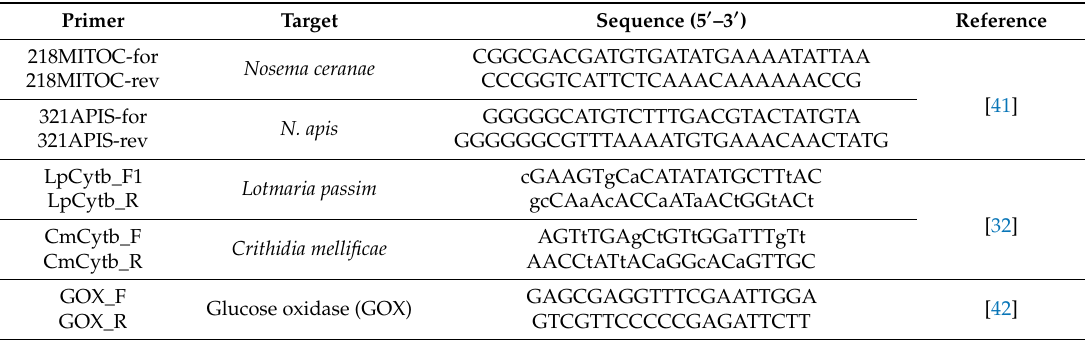
Table 1. Primers used in this